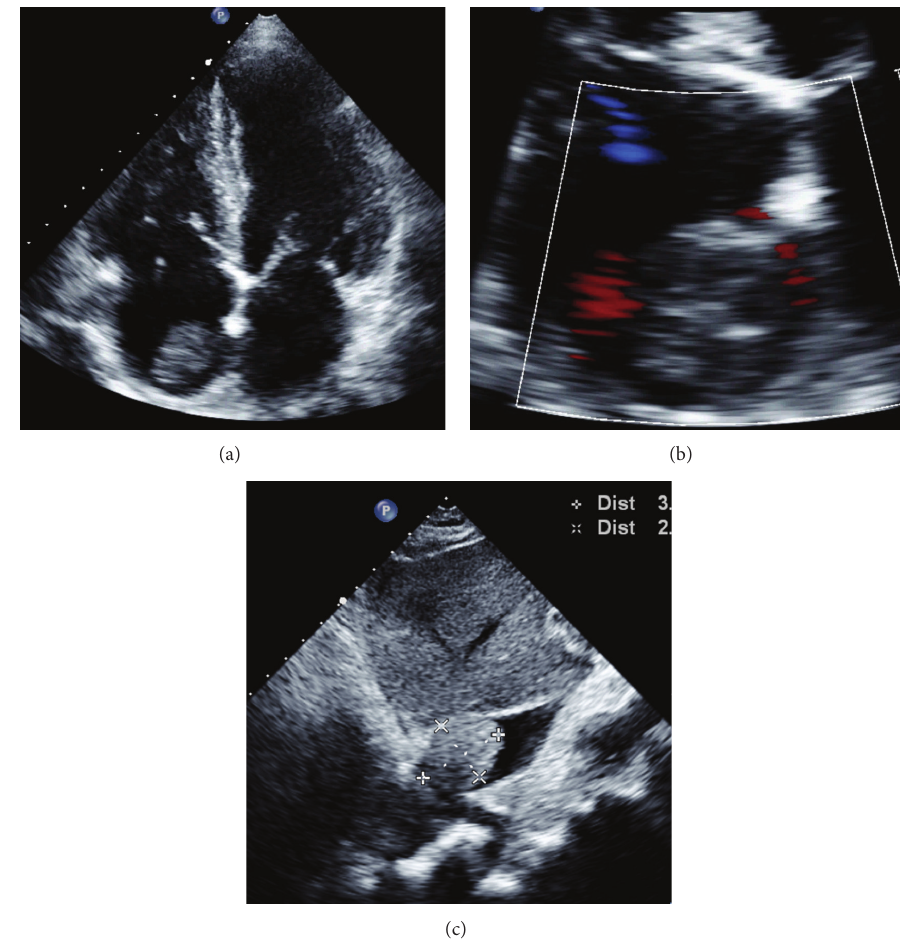
Figure 2: Transthoracic